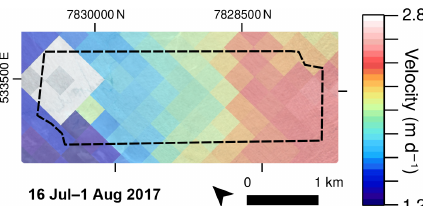
Figure 10. Landsat 8 OLI-derived velocity field of the study area between 16 July and 1 August 2017. Data are from the GoLIVE project (Fahnestock et al., 2016, resolution = 300m) overlaid onto Sentinel-2 optical imagery. The black outline marks the extent of the study zone in Fig. 7. Note that feature tracking has failed over the site of the former lake